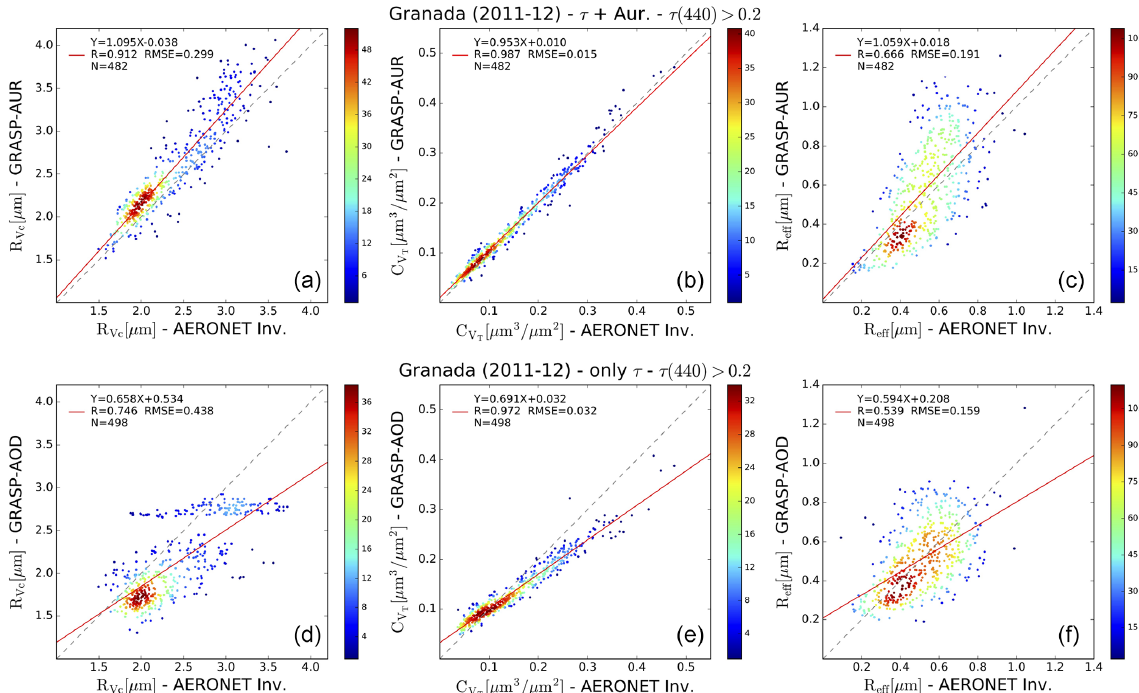
Figure 14. Comparisons between the coarse-mode volume median radius ( R Vc [µm]; a, d ), the total volume concentration ( C V b, e ) and effective radius ( R eff [µm]; c, f ) obtained by the GRASP code and AERONET aerosol retrieval algorithm for the Granada site for the biennium 2011–2012. In the retrievals in (a) – (c) , we have used τ measurements and aureole measurements between 3.5 and 10 ◦ azimuth angle as input (GRASP-AUR application). The retrievals in (d) – (f) only contain τ measurements as input (GRASP-AOD retrievals). In all the retrievals, we have added the filter τ( 440 ) > 0 . 2. Color bars represent data density in a 0 . 2 × 0 . 2µm grid for R Vc and R eff and in 0 . 02 × 0 . 02µm 3 /µm 2 grid for C V T